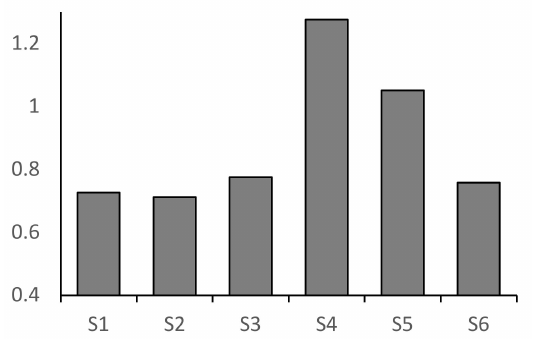
Figure 5. Water pollution index (WPI) at different study locations.